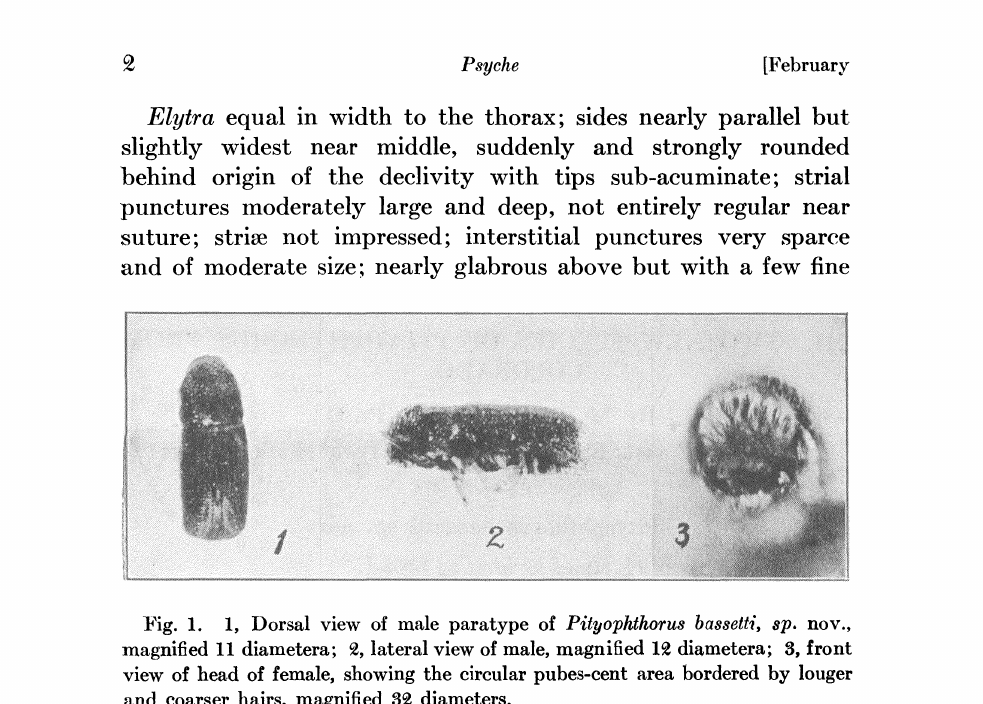
, Fig. 1. 1, Dorsal view of male paratype of Pityophthorus bassetti, sp. nov., lateral view of male, magnified 1 diametera; 3, front magnified 11 diametera; view of head of female, showing the circular pubes-cent area bordered by louger and coarser hairs, magnified 3